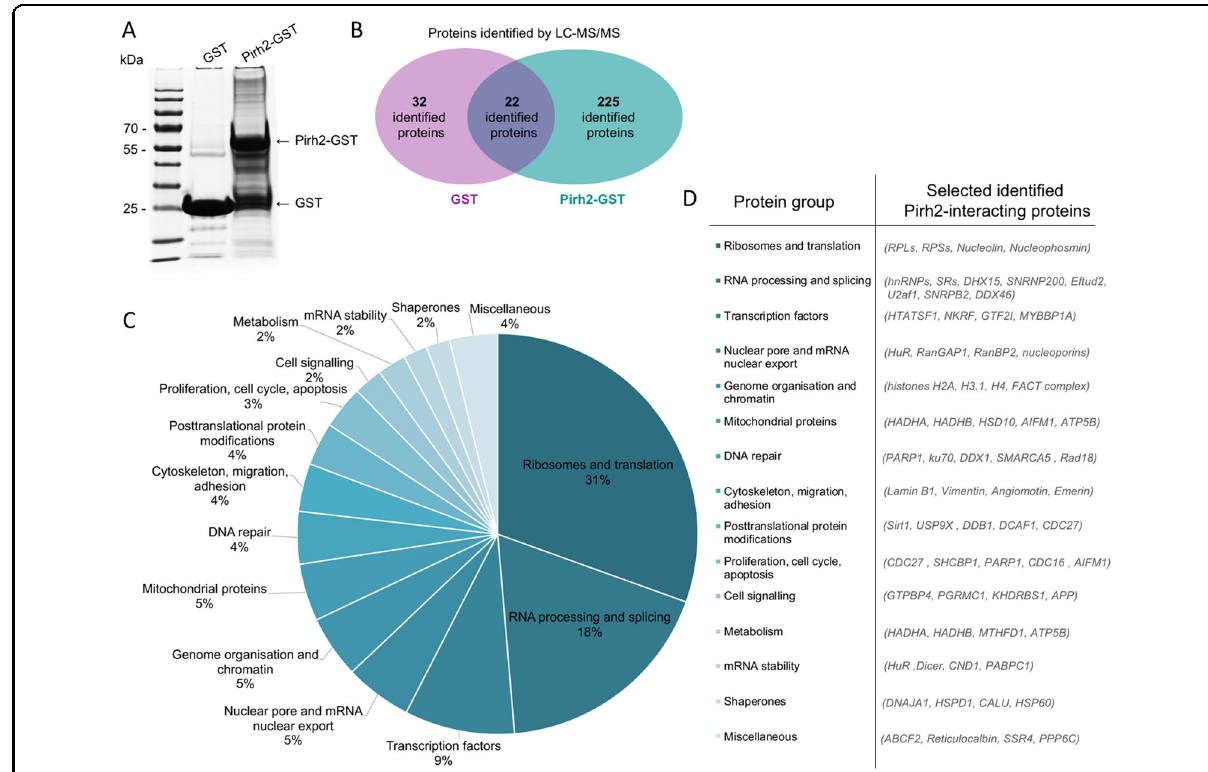
Fig. 1 Interactome of Pirh2. A Coomassie-stained gel of GST and Pirh2-GST proteins after incubation with cell extracts from HEK293T. Pirh2-GST fusion protein and native GST protein are denoted with arrows. The mass spectrometry data were processed using Mascot49 and Scaffold 4 software. B Euler diagram demonstrating the number of GST- and Pirh2-GST-interacting proteins identi fi ed by LC-MS/MS. C A pie chart of identi fi ed Pirh2- interacting proteins grouped by their functions. D The list of functionally distinguished groups with selected representative proteins that interact with